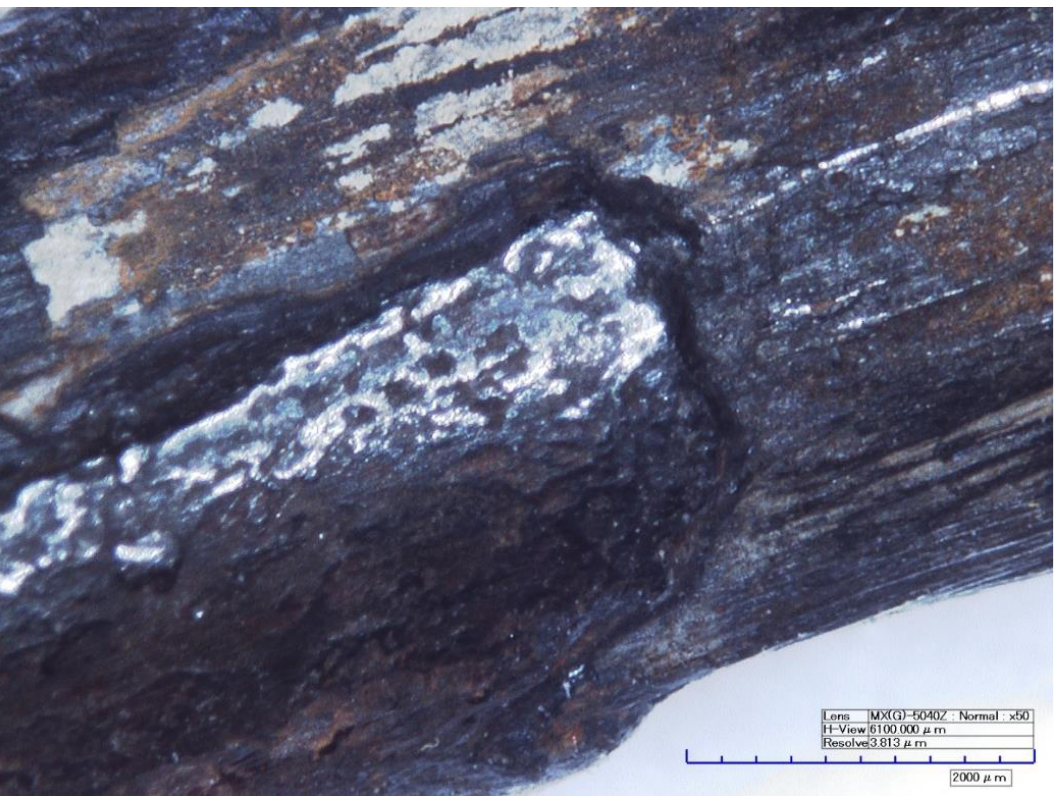
Figure 5. The length of the greatest detected surface corrosion damage.